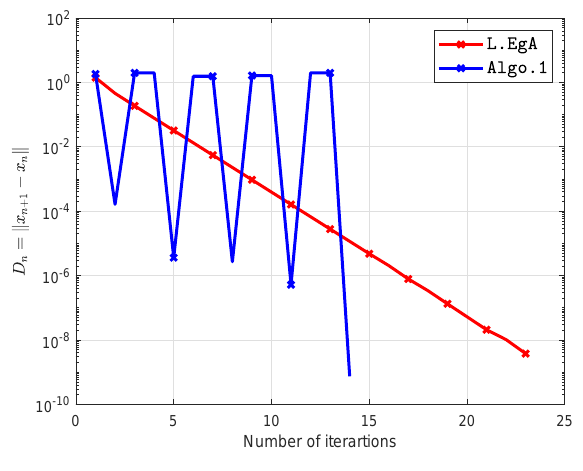
Figure 11. Example 3 while u 0 = ( 1,2 ) .